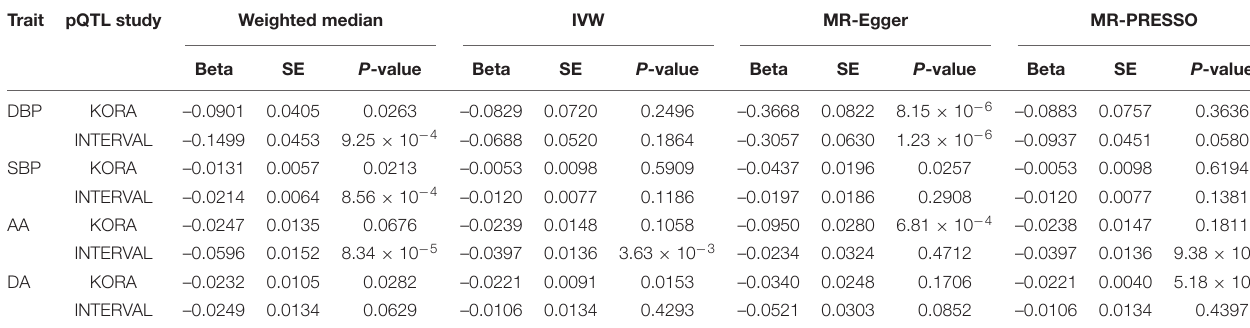
TABLE 4 | The causation between circulating cathepsin B level and BP and aortic